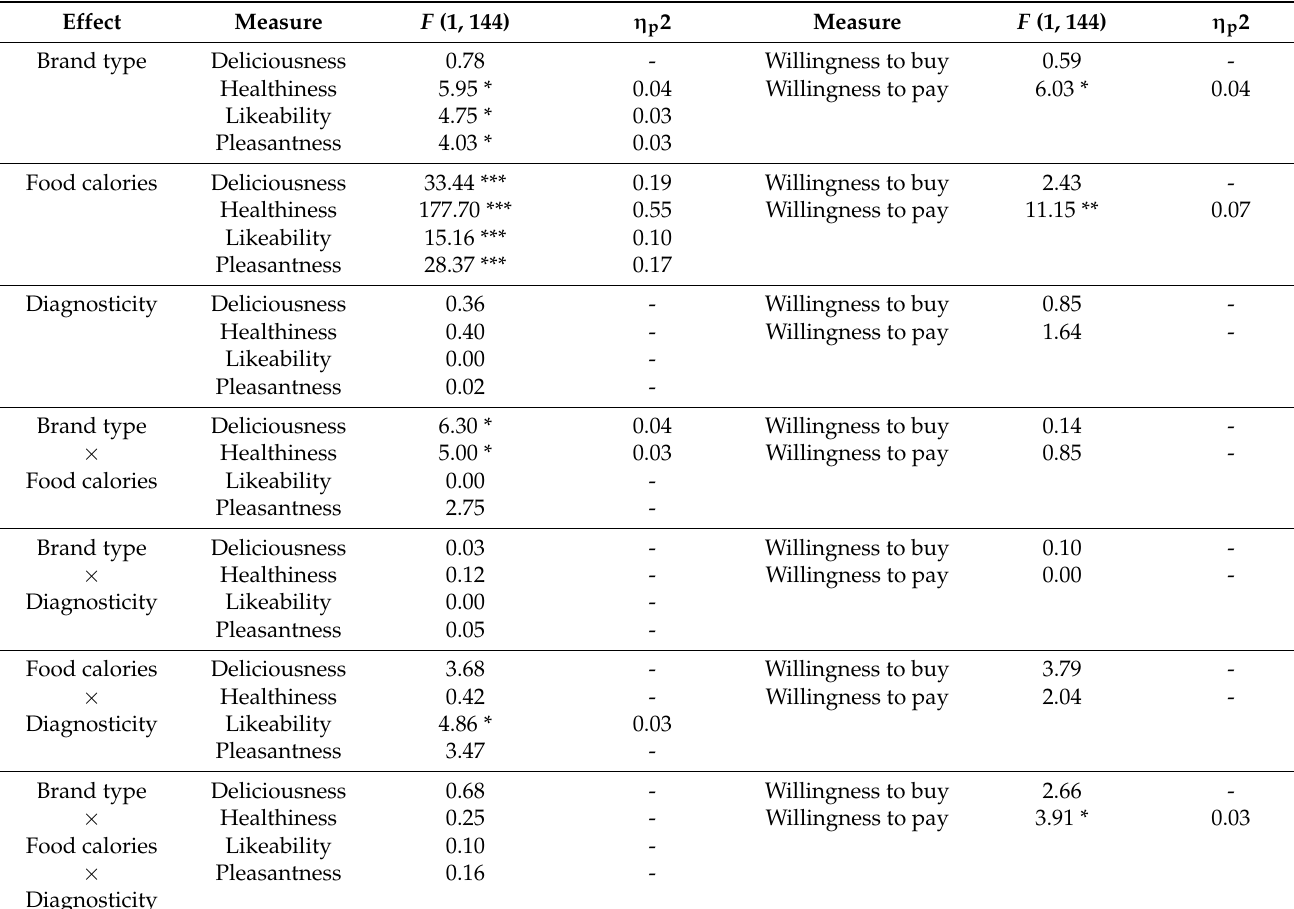
Table 2. The results of ANOVAs conducted on the data collected in Study 2.